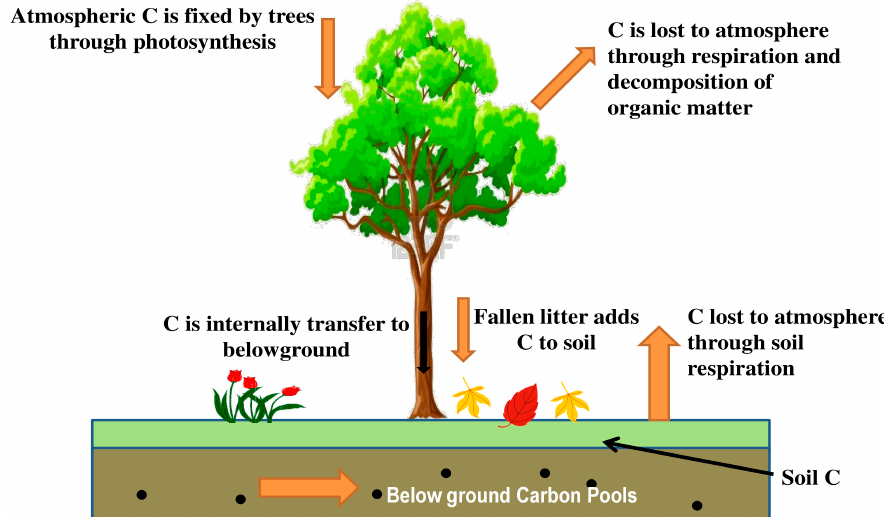
Figure 2. The process of carbon sequestration through trees.